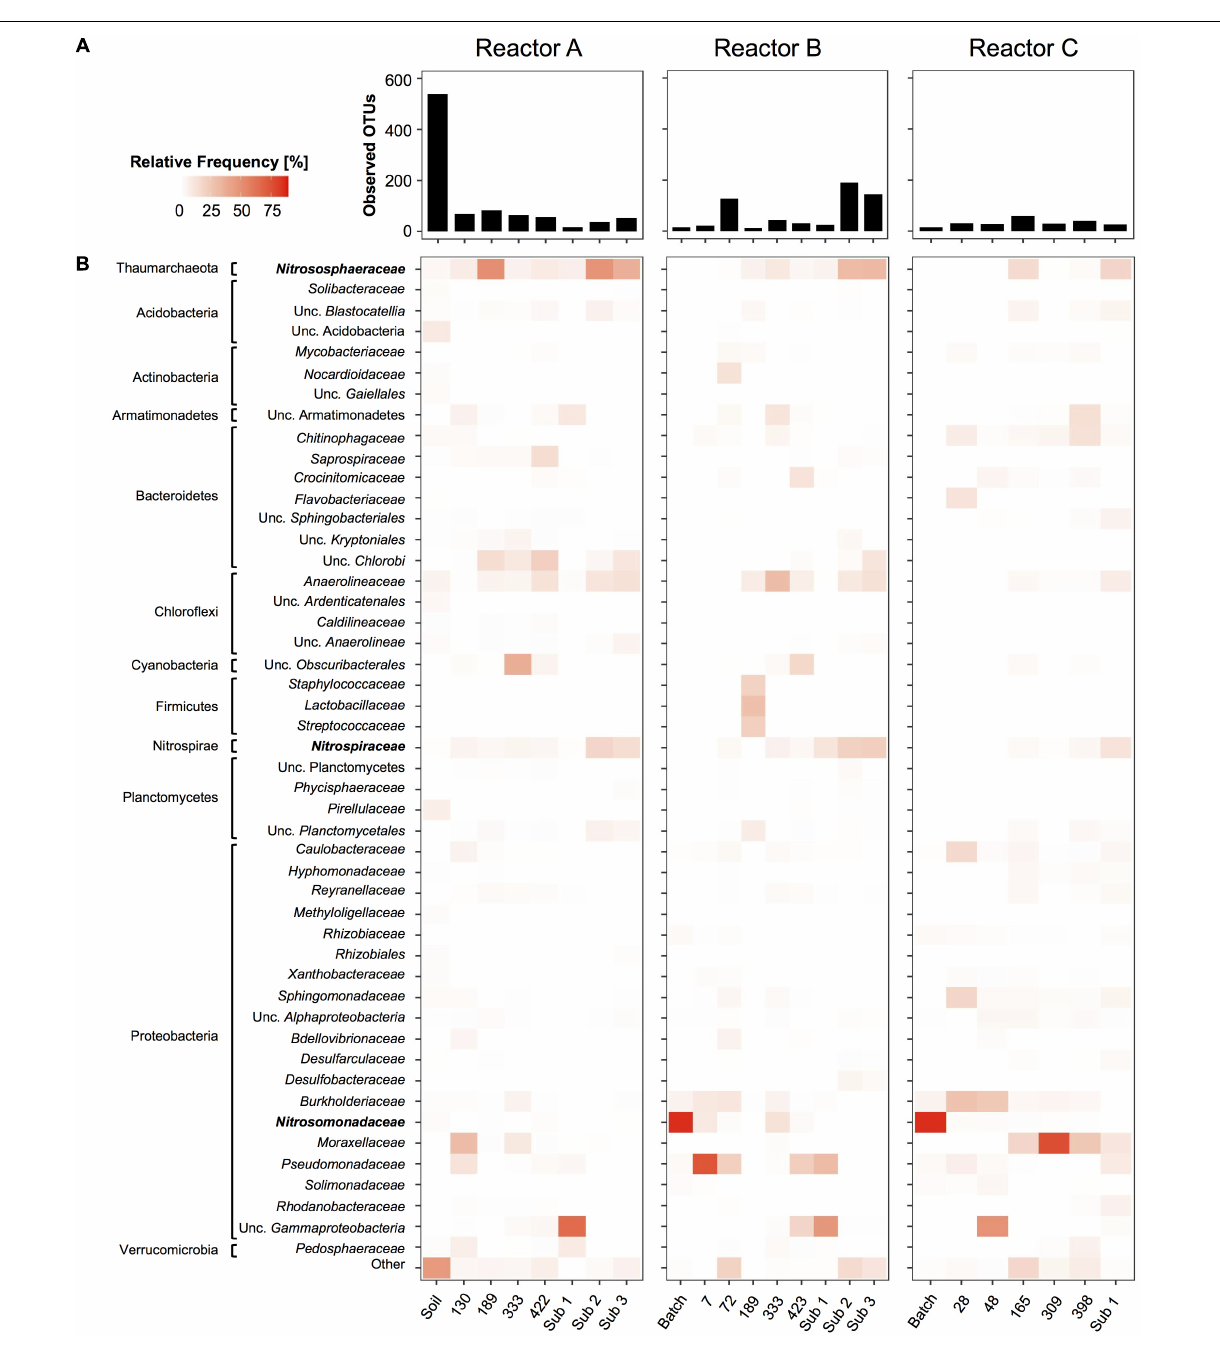
FIGURE 6 | Time series of overall community composition in reactors A, B, and C based on 16S rRNA gene amplicon sequences. Given are overall diversity of bacterial and archaeal taxa as Observed OTU’s at ASV level (bar graphs, A ) and relative frequency of microbial taxa summed and grouped at the family level (heatmaps, B ). Family level taxa with more than 1% relative frequency in at least one sample are shown on the left. All other less frequent taxa were grouped into “Other.” For uncultivated taxa without family level taxonomic names next higher level of taxonomic names are given. Nitrifier taxa highlighted in bold are analyzed in more detail in Figure 3 . Sub 1, Sub 2, and Sub 3 refer to sub-culture